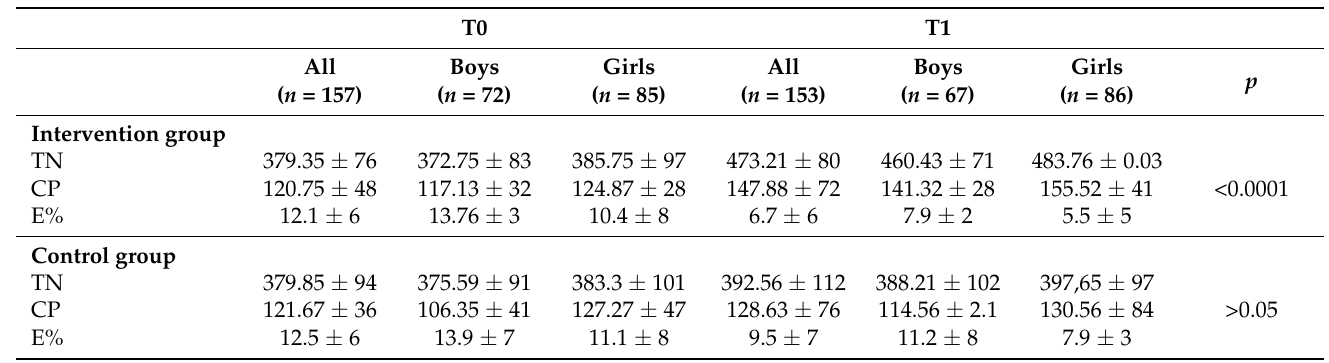
Table 4. The d2 test performance.